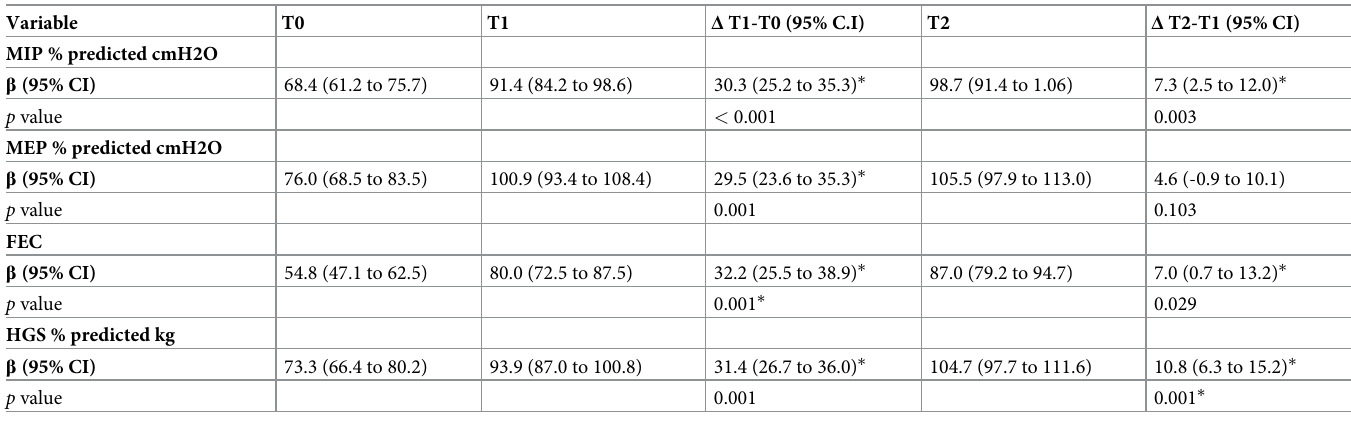
Table 2. Linear mixed model analysis for longitudinal changes in MIP, MEP, FEC and HGS.